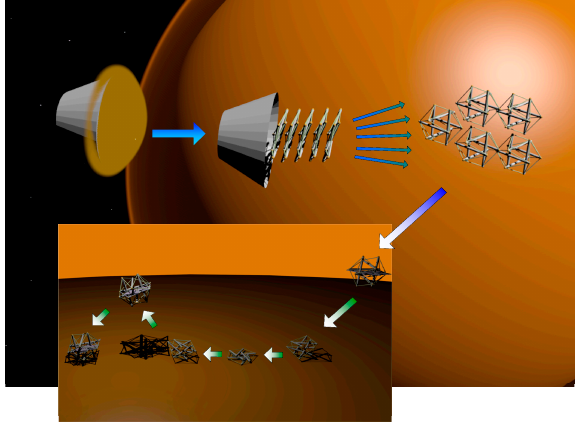
Figure 1. Schematic diagram of the exoplanet exploration mission [10].